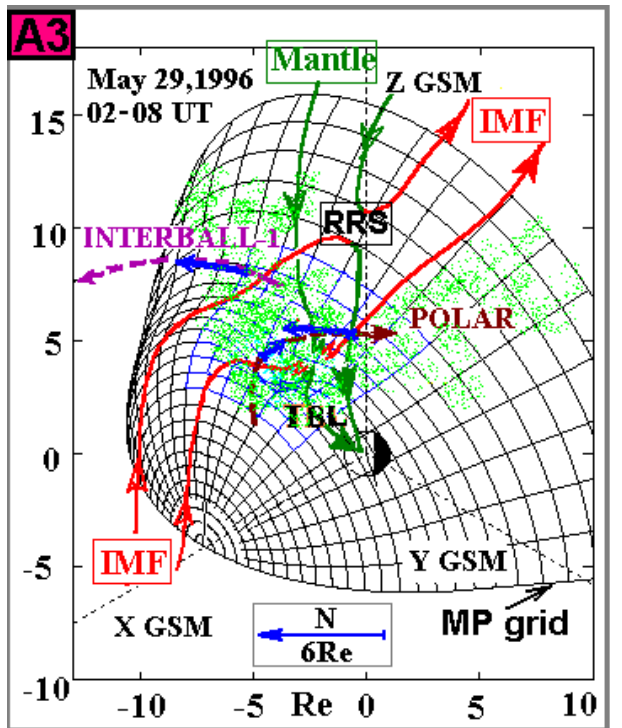
Plate A3. Sketch for reconnection at the indented magnetopause during northward IMF conditions on 29 May 1996. The black mag- netopause (MP) grid is described in Sect. 6.2. Polar and Interball-1 orbits are shown by the dashed brown and violet lines, respectively. The TBL from Fig. 8 is depicted by green dots. The measured MP normals are marked by blue arrows (the total normal length is shown at the bottom of the figure by a blue arrow marked by “N”). The draped IMF magnetic field lines are marked by a red color, the magnetospheric/ mantle lines – by a green color.